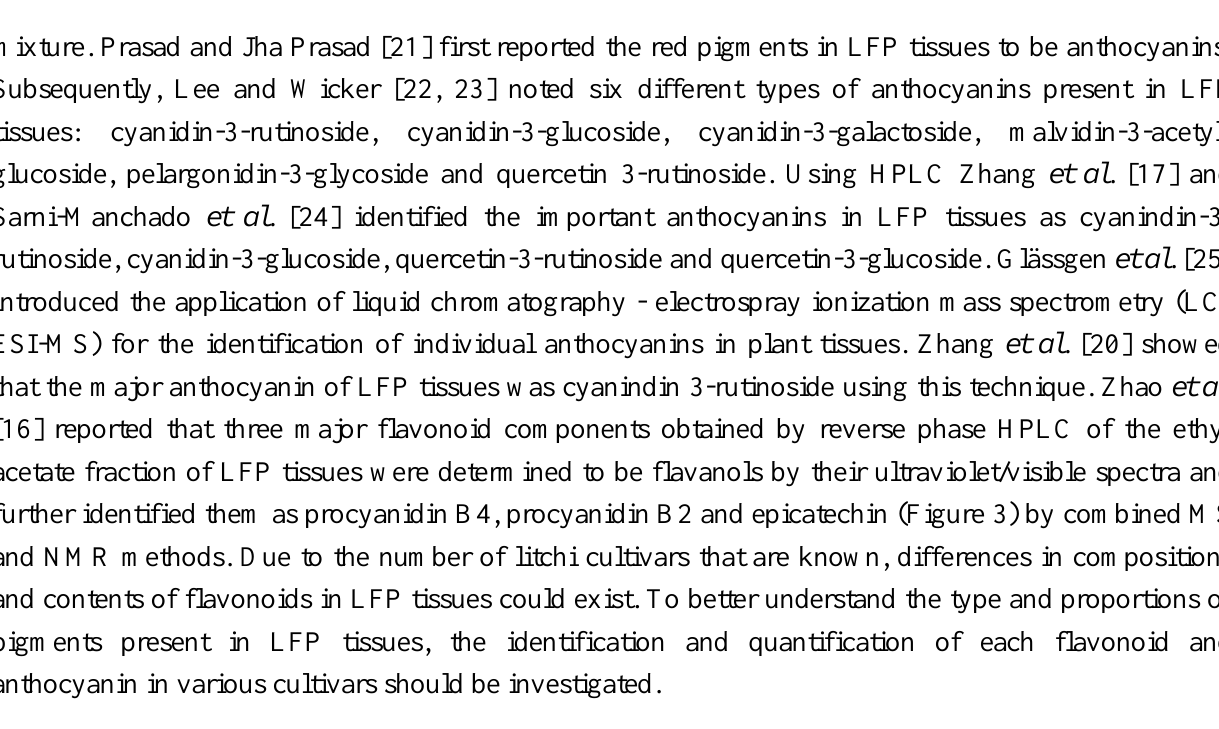
Figure 3. Molecular formulae of epicatechin, procyanidin B2 and procyanidin B4.